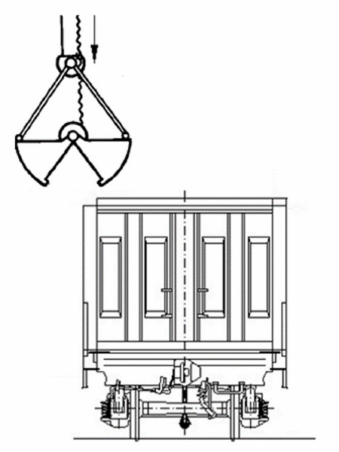
Figure 5. Computational model scheme of a gondola